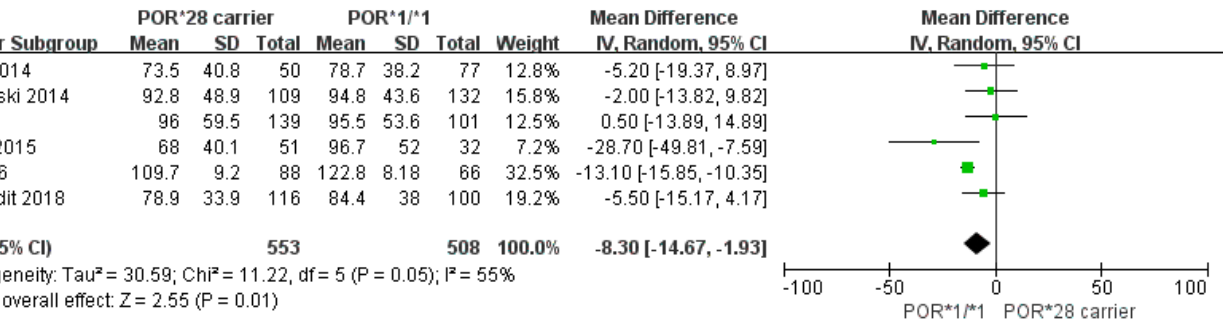
Figure 2. A forest plot showing the association between POR*28 carriers and standardized trough concentration (ng/mL per mg/kg) of tacrolimus.